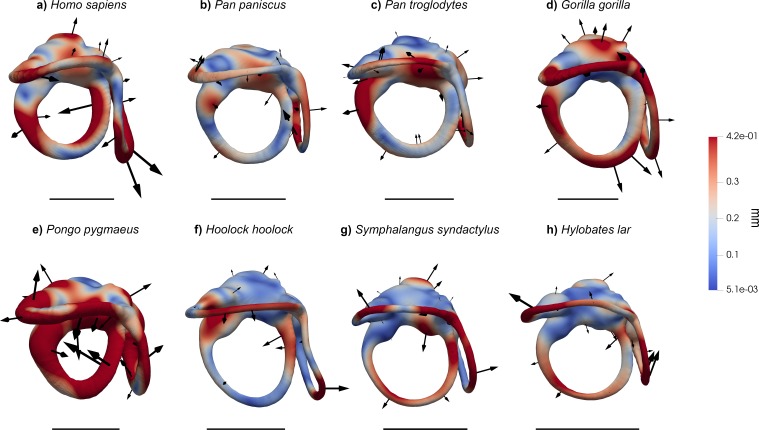
Results of the 3DGM deformation-based analysis superimposed on the vestibular apparatus of hominoids, in superior view.Cumulative displacement variations are rendered by pseudocolor scale ranging from dark blue (<5.1 µm) to dark red (0.42 mm). Black arrows correspond to the vectors identifying the direction and amount of displacement. (a) Homo sapiens (EMBR 121); (b) Pan paniscus (MCZ 38019); (c) Pan troglodytes (AMNH.M 51204); (d) Gorilla gorilla (AMNH.M 167338); (e) Pongo pygmaeus (IPS10647); (f) Hoolock hoolock (AMNH.M 83425); (g) Symphalangus syndactylus (AMNH.M 106583); (h) Hylobates lar (MCZ 41424). Scale bars equal 5 mm. Hominids (a–e) differ from other anthropoids in the stouter semicircular canals, except for the lateral canal of Ateles. Among great apes, Pongo (e) displays the most inflated canals and a uniquely displaced lateral semicircular canal, Pan (b, c) has the least derived morphology, and Gorilla (e) possesses a laterally protruding lateral canal. Homo (a) combines a slight (variable) reduction of the lateral canal with an enlarged posterior canal. Hylobatids (f–h) show an obtuse angle between the posterior and the anterior SCs.